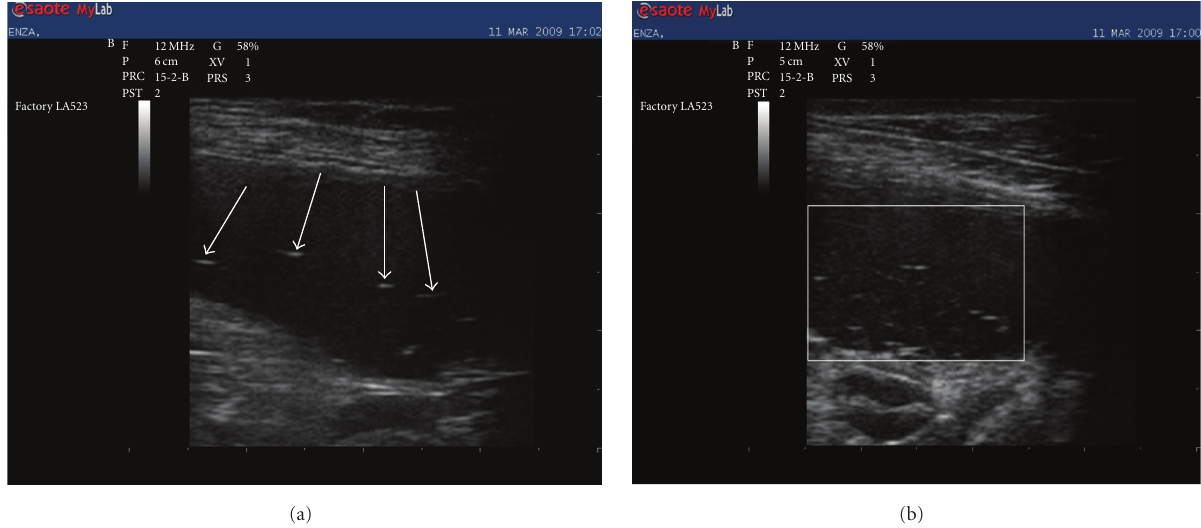
Figure 2: Abdominal ultrasonography (linear probe 10MHz). In di ff erent views, the bowel appears distended by fluid with several thin linear hyperechoic objects (arrows (a)) (white square (b)) floating within the